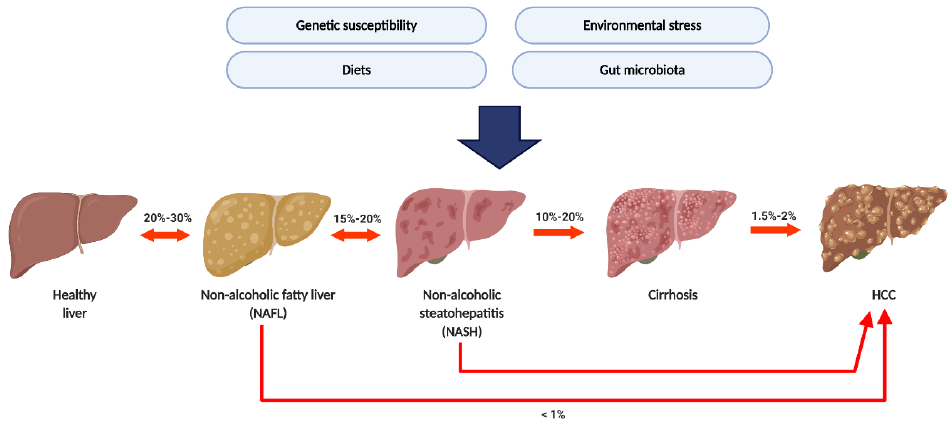
Figure 1. The natural history of non-alcoholic fatty liver disease (NAFLD) and its etiological risk factor. The prevalence of NAFL was around 20 – 30%. Around 15 – 20% of non-alcoholic simple fatty liver (NAFL) patients developed non-alcoholic steatohepatitis (NASH); 10 – 20% of NASH patients will further process to cirrhosis and Hepatocellular carcinoma (HCC). Several factors including genetic susceptibility, environmental stress, diet, and gut microbiota were considered as etiological risk factors.